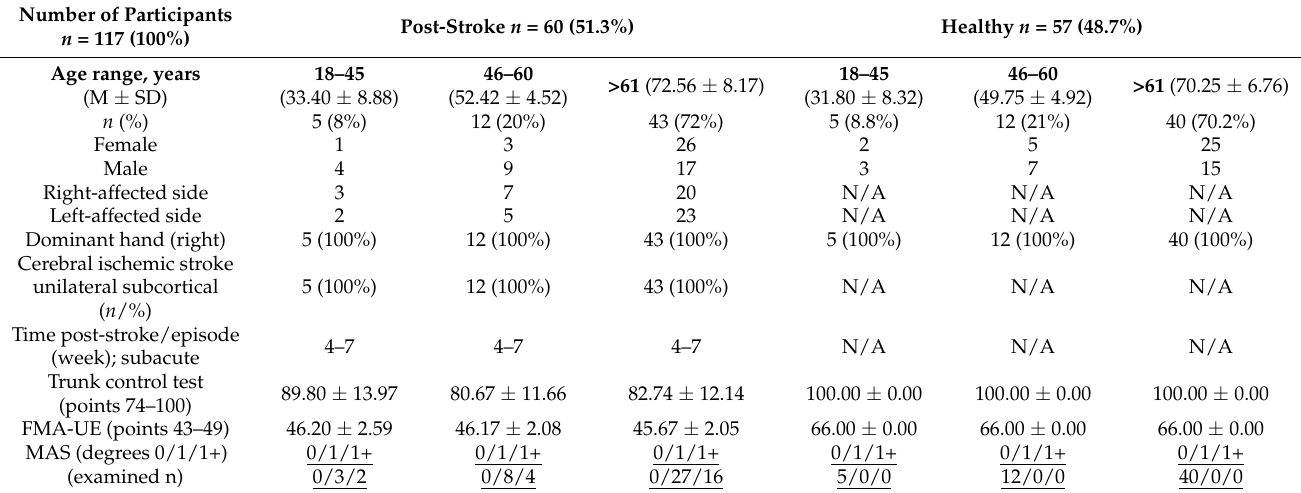
Table 2. The epidemiological data of post-stroke patients and healthy control